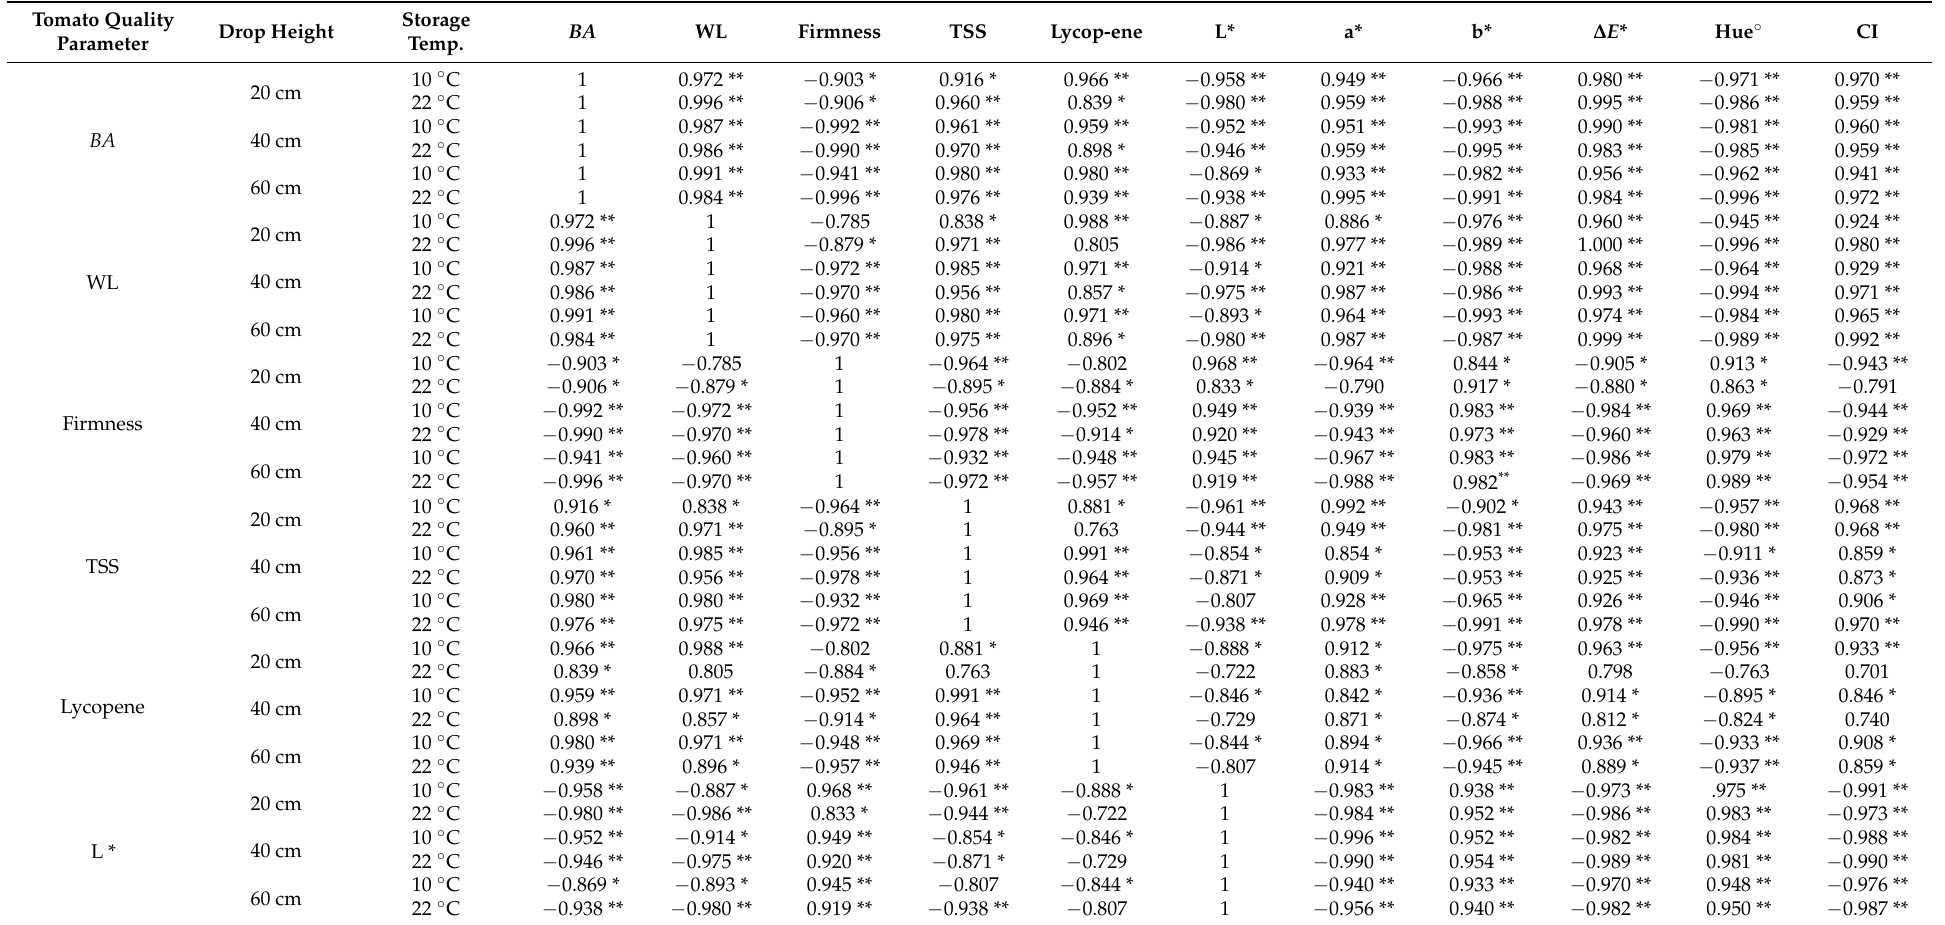
Table 3. Pearson correlation coefficients (r) ( n = 6) between quality attributes on tomato subjected to an impact from three different heights and stored at 10 ◦ C and 22 ◦ C. Significant correlations of two-tailed tests are indicated: * p < 0.05; ** p < 0.01. Tomato Quality